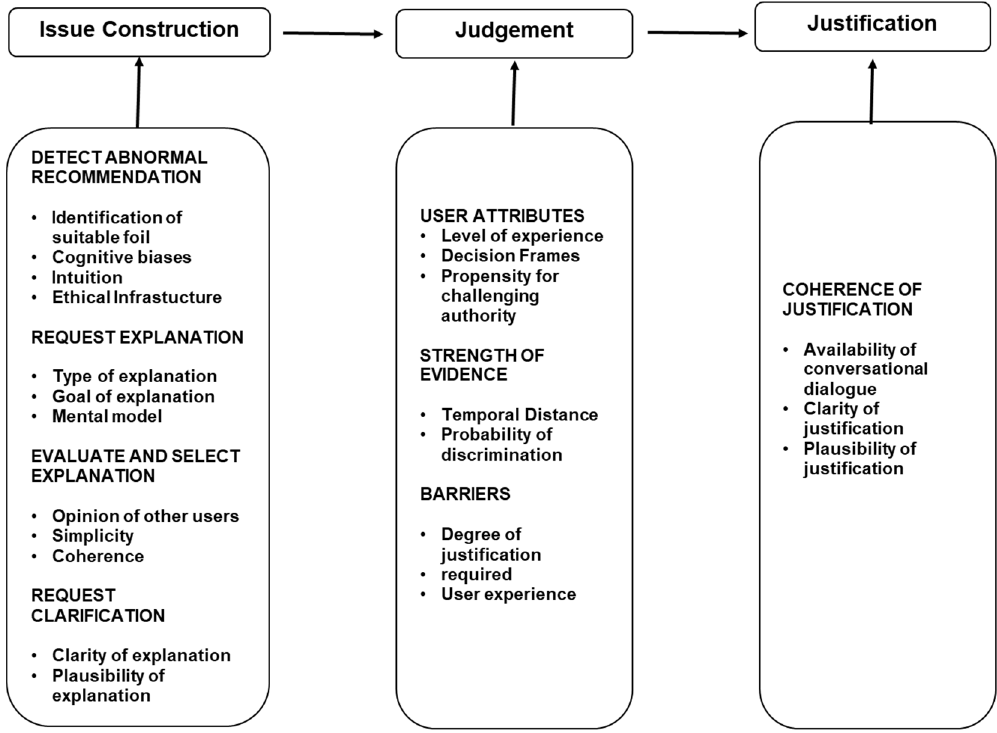
Figure 2. Synthesised model of ethical decision making with Intelligence Augmentation.